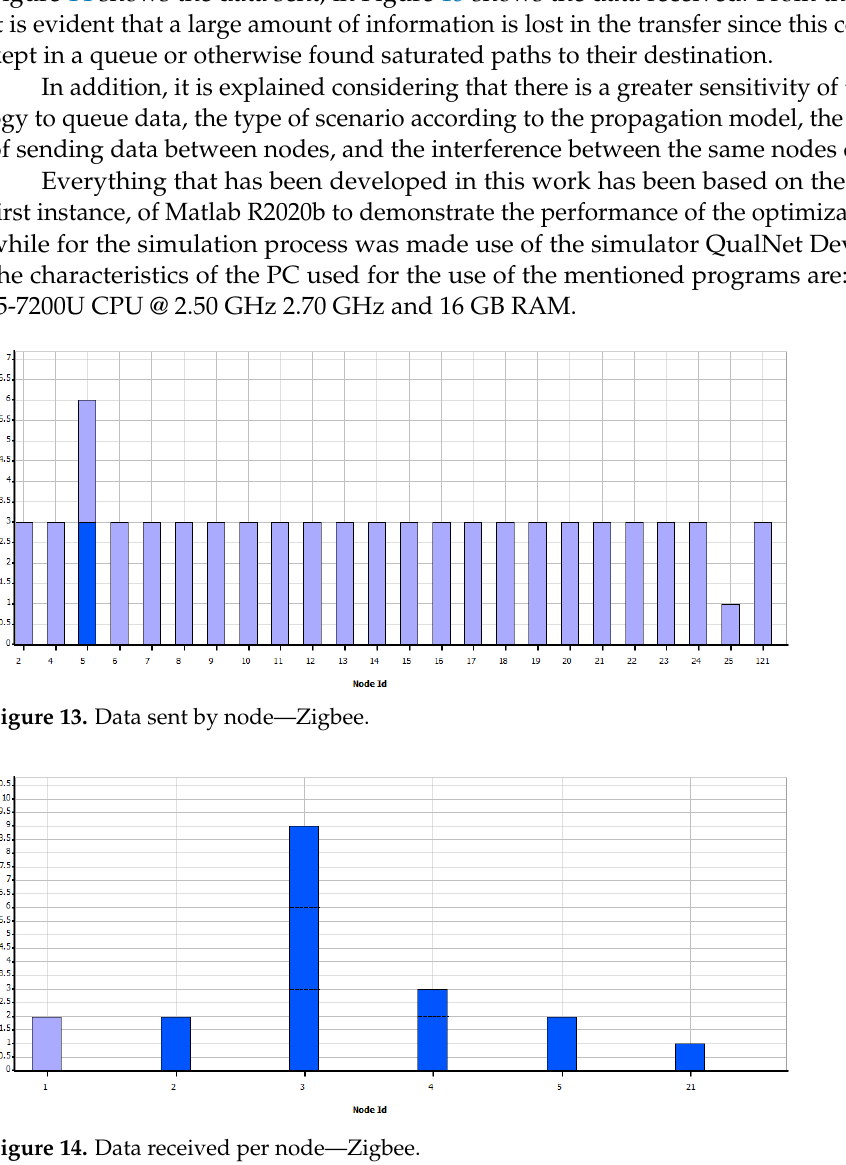
Figure 14. Data received per node—Zigbee.